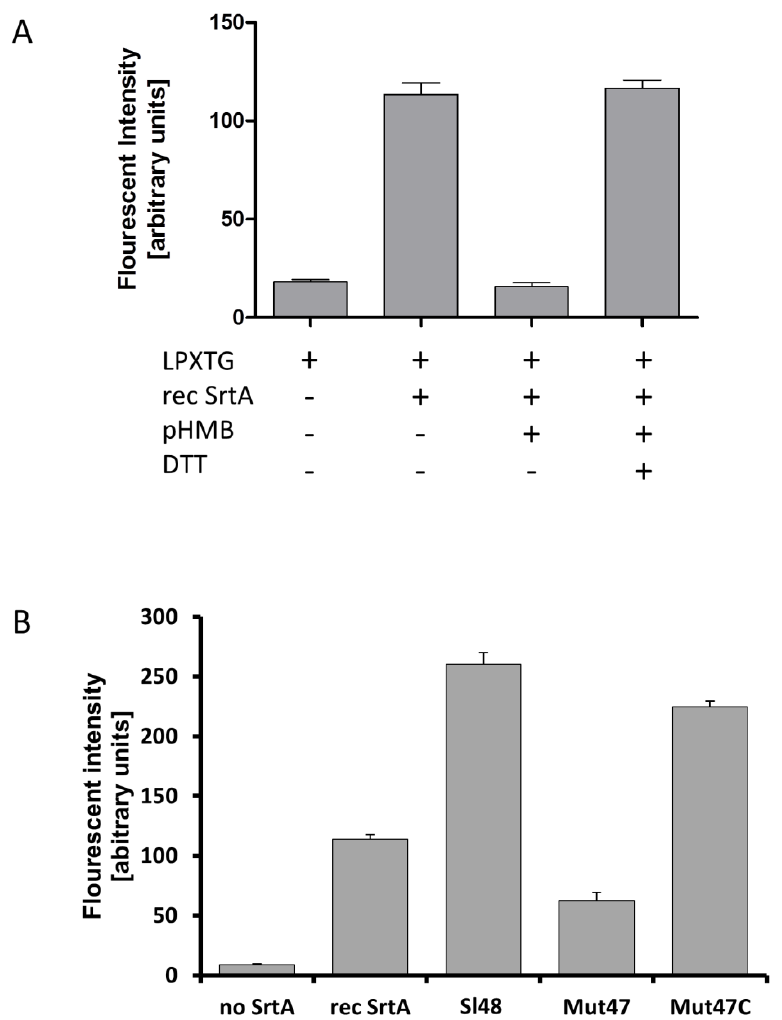
Figure 5. Hydroxylaminolysis of LPXTG peptide by recombinant SrtA ( A ) and whole S. lugdunensis cells ( B ). ( A ) Recombinant SrtA was incubated with the sorting substrate Dabcyl-QALPETGEE-Edans (LPXTG), and peptide cleavage was monitored as an increase in fluorescence. The reactions were influenced by the addition of pHMB (inhibitor of sortase activity) and by DTT. Presence and absence of the respective substance is shown as “ + ” or “-“, respectively. ( B ) Same assay using the LPXTG substrate, recombinant SrtA, S. lugdunensis cell extracts from the wild-type strain Sl48, ∆ srtA mutant Mut47 and complemented Mut47C. All results are shown as the mean of three independent experiments with the standard deviation (SD).